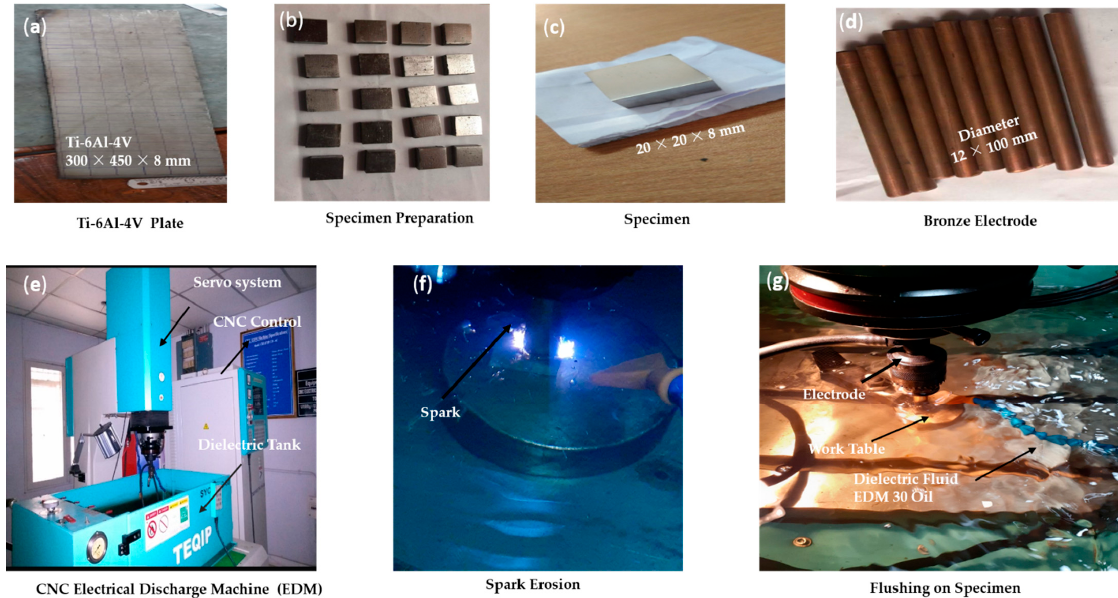
Figure 5. Experimental Setup of EDC coating: ( a ) Ti-6Al-4V Plate, ( b ) Specimen preparation, ( c ) Specimen, ( d ) Bronze electrode, ( e ) CNC electrical discharge machine, ( f ) Spark erosion, and ( g ) Flushing on the specimen.